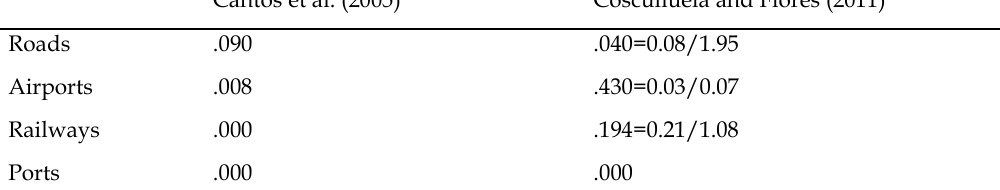
Table 1. Long Run Output